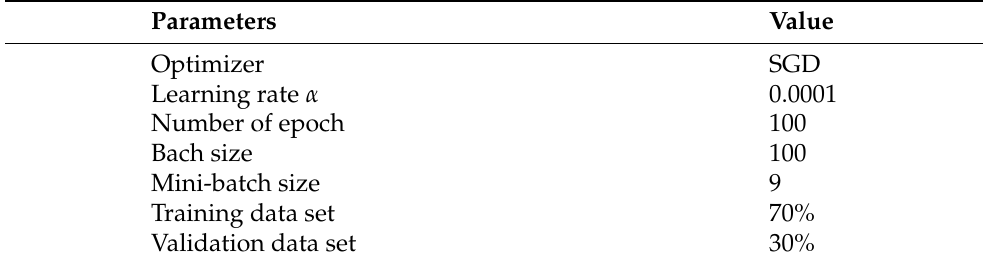
Table 2. R2DCNNMC model